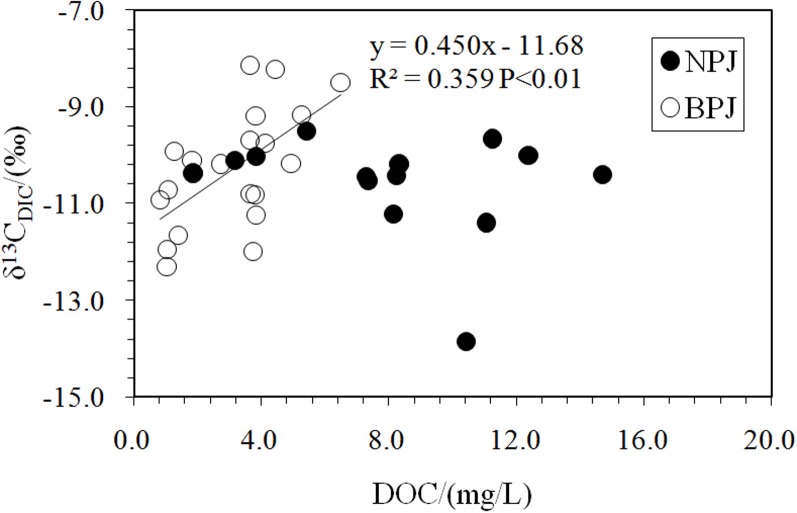
Correlation between δ13CDIC and DOC content.The trend line applies only to BPJ; no statistically significant relationship exists for NPJ. DOC data cited from Zou (in review).